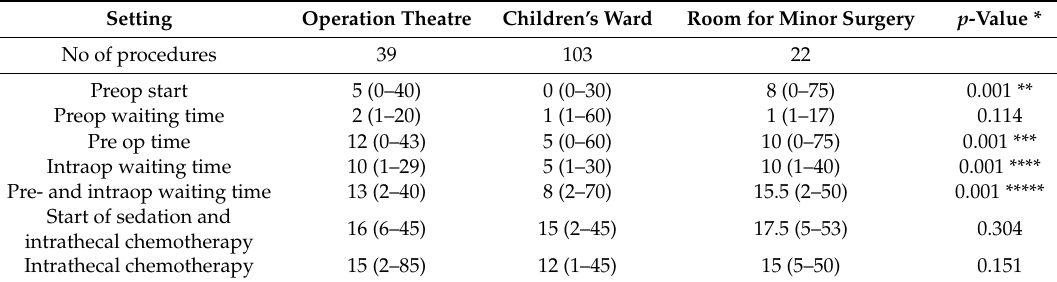
Table 2. Time intervals (min), median (range).